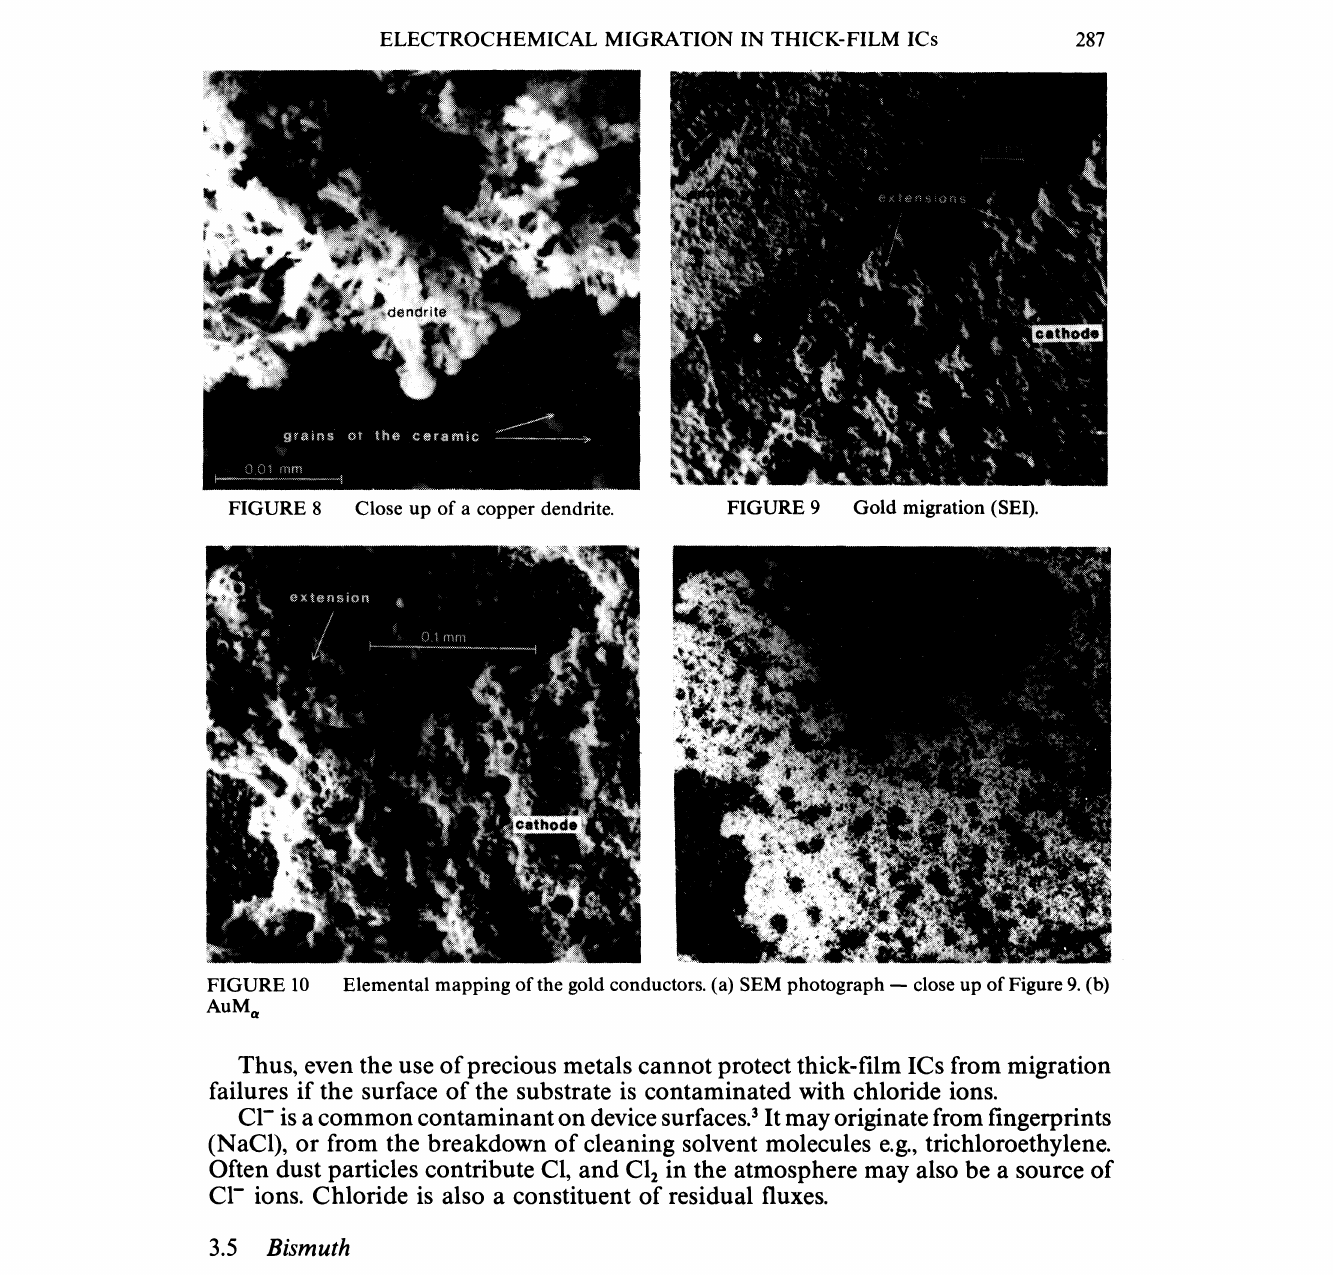
FIGURE 10 Elemental mapping ofthe gold conductors. (a) SEM photograph close up of Figure 9. (b)